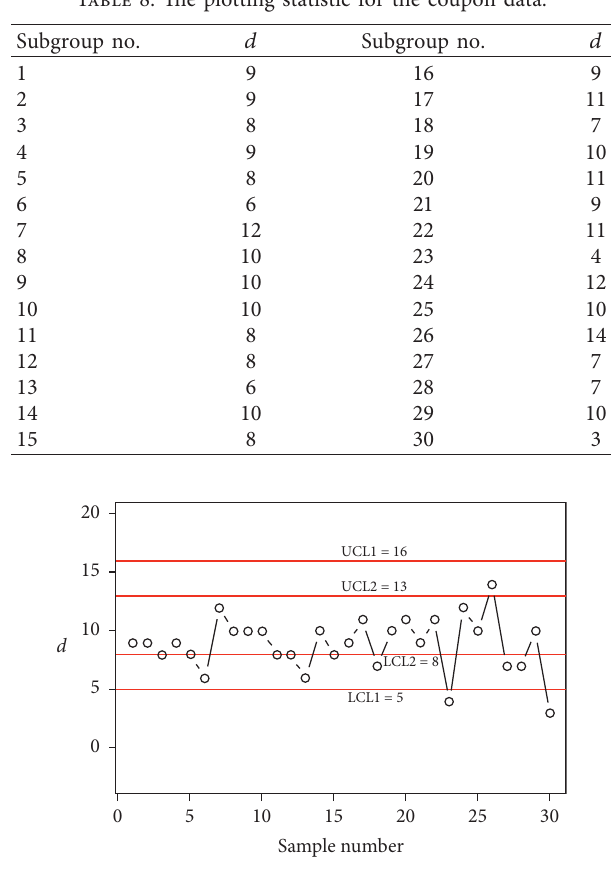
Figure 4: The Birnbaum–Saunders chart based on the MDSRS method for the coupon data.